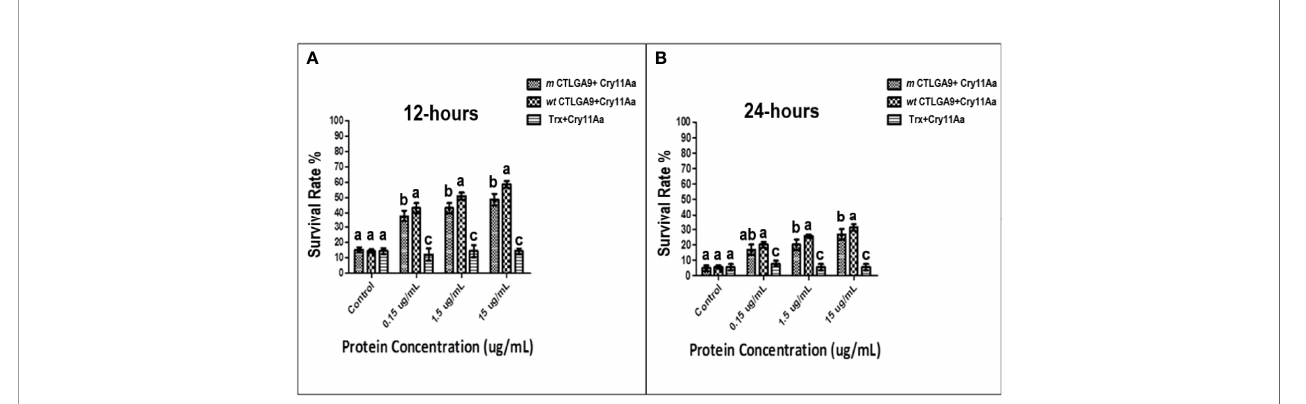
FIGURE 5 | Feeding assay of Cry11Aa in the presence of recombinant m CTLGA9 fusion protein. A. aegypti larvae were fed with puri fi ed Cry11Aa (0.85 m g/mL) mixed with increasing concentrations of recombinant and control protein as wt CTLGA9 or Trx protein (0.15, 1.5, 15 m g/mL), and the mosquito larvae survival rate was noted at 12 h (A) and 24 h (B) of treatment with three replicates. Signi fi cance of difference was calculated by one way ANOVA followed by Tukey HSD test using IBM SPSS version 22 (A, B) , and identical letters are not signi fi cantly different (p > 0.05) while different letters indicate signi fi cant difference (p < 0.05).